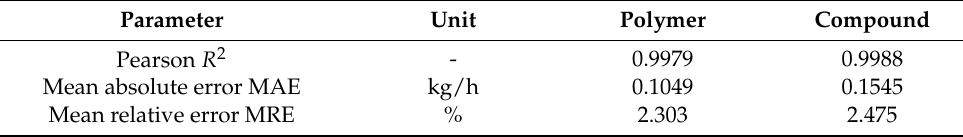
Table 7. Error analysis of the symbolic regression